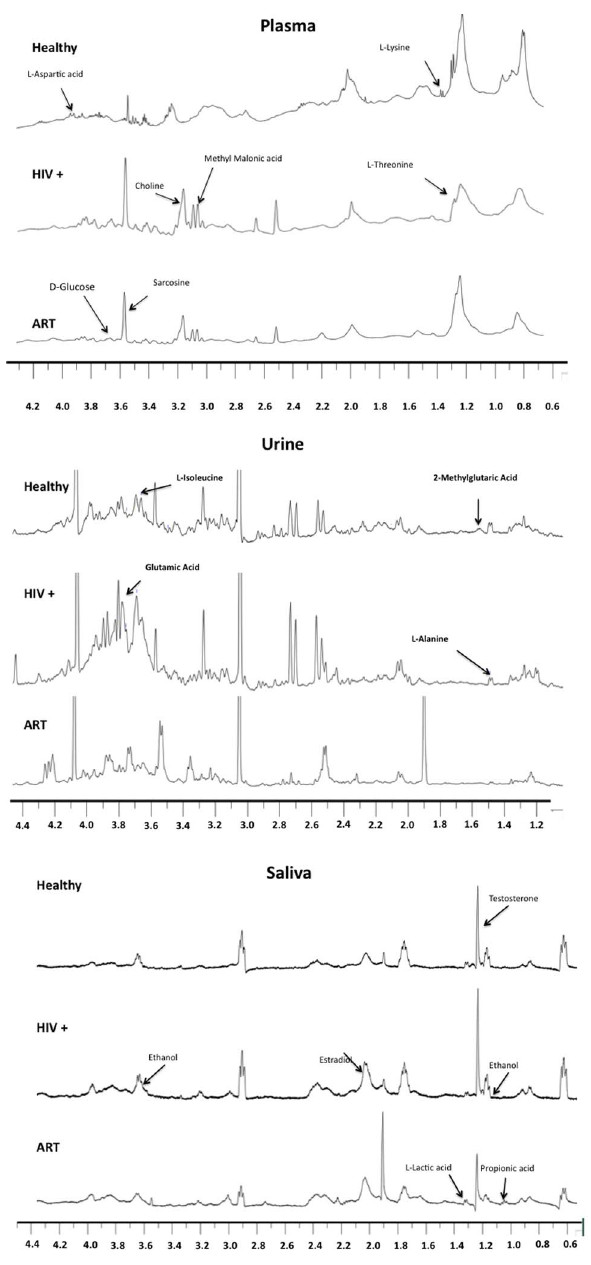
Figure 1. Representative one-dimensional 1 H NMR spectra of plasma, urine, and saliva obtained from a healthy control, a HIV/AIDS patient, and a patient on ART. The differences in the intensity of metabolites in different samples are indicated with